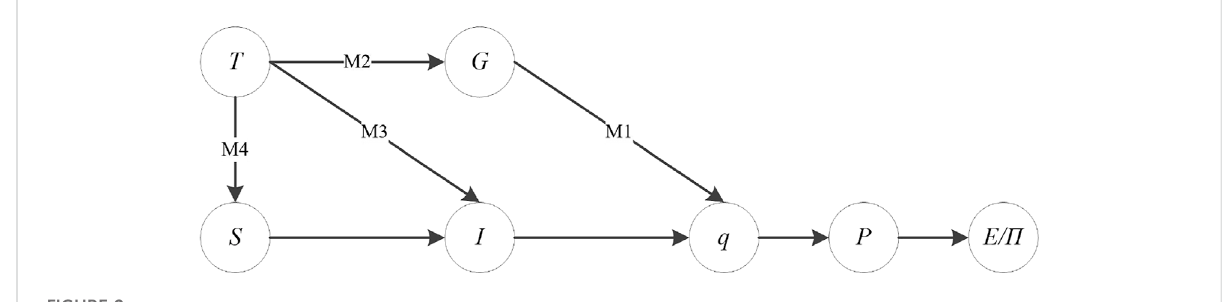
FIGURE 2 Impact path of the DP model.